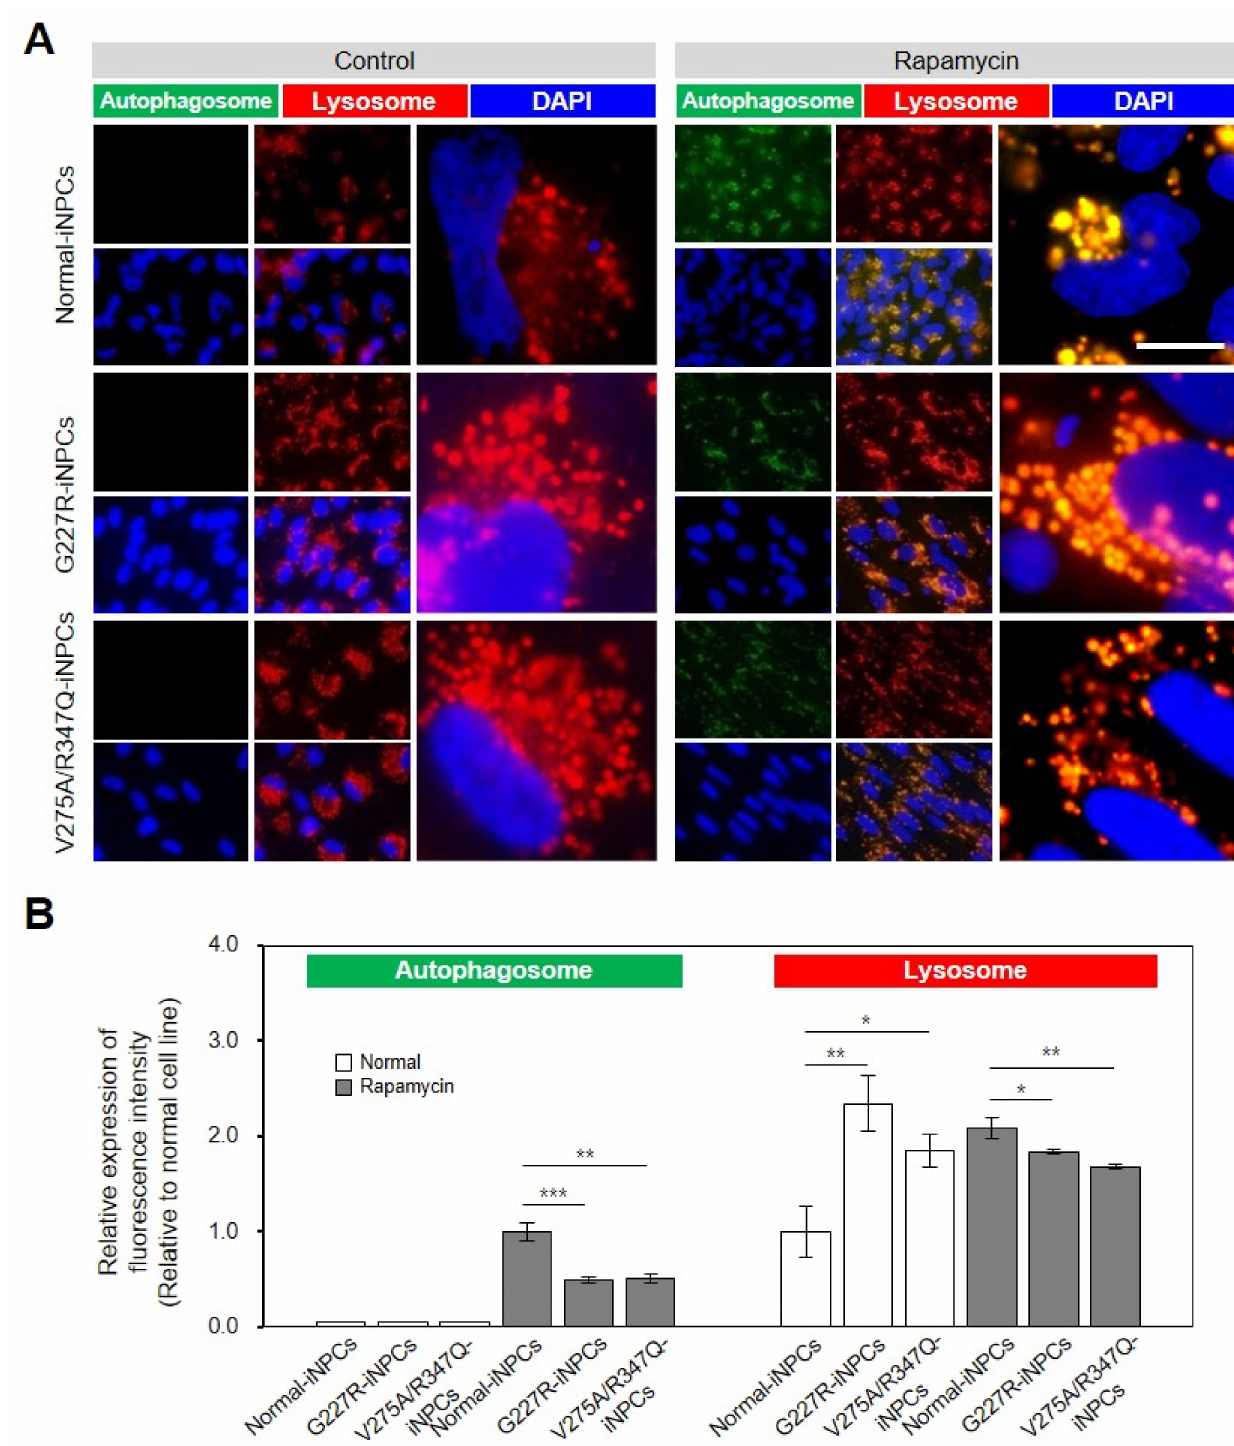
Figure 4. Lysosomal and autophagic dysfunctions in sialidosis-iNPCs. ( A ) Representative images show the LYSO-ID-stained lysosomal (red) and CYTO-ID-stained autophagosomal (green) compartments in normal- and sialidosis-iNPCs cultured in the absence (control, left panel) or presence of rapamycin (500 ng/mL, right panel). Nuclei were counterstained with DAPI (blue). (Scale bar = 10 µ m) ( B ) Quantification of the autophagosomal and lysosomal compartments from Figure 4A images to measure the relative expression of fluorescence intensity. The data are the means ± SDs of at least 3 independent experiments. * p < 0.05, ** p < 0.01, and *** p < 0.001, compared to control normal-iNPCs ( t